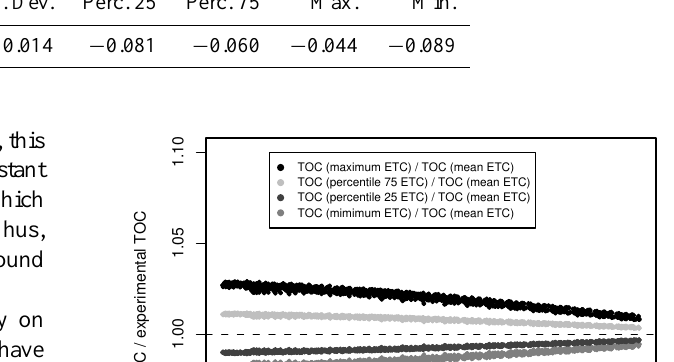
Table 1. Statistical parameters derived from the determination of the daily extraterrestrial constant of the Bentham spectroradiometer by the Langley technique for the 30 selected cloud-free half-days. The parameters are the following: the mean, the median, the standard deviation, percentiles 25 and 75, maximum and minimum. Mean Median Stand. Dev. Perc. 25 Perc. 75 Max. Min. ETC − 0.071 − 0.074 0.014 − 0.081 − 0.060 − 0.044 − 0.089